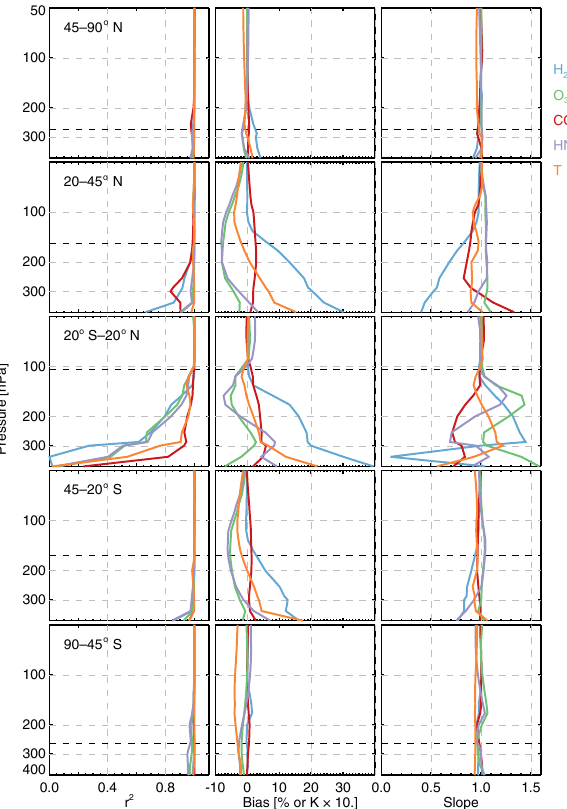
Figure 7. As in Fig. 6 but using only the profiles that passed the quality